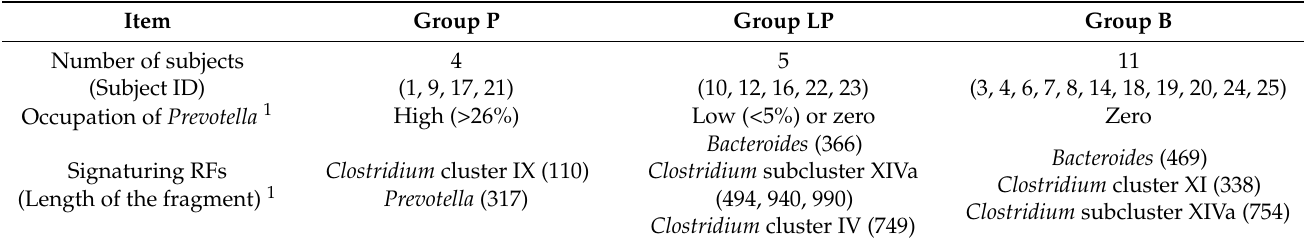
Table 4. Characteristics of the groups divided by the T-RFLP patterns representing fecal bacterial community structure.